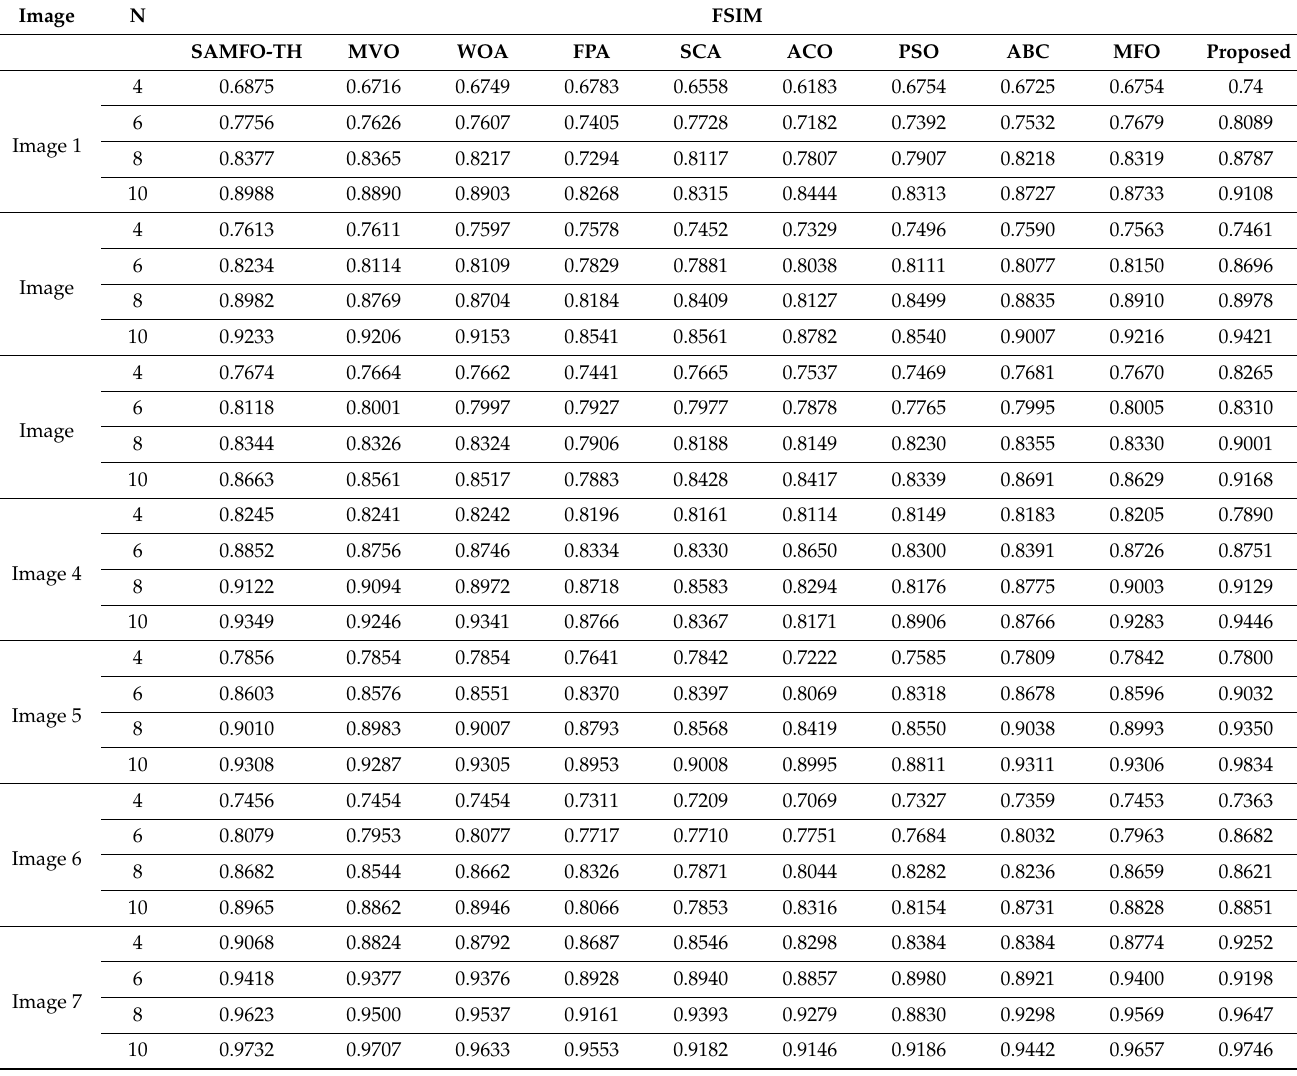
Table 5. Comparison of FSIM computed by SAMFO-TH, MVO, WOA, FPA, SCA, ACO, PSO, ABC, and MFO with the proposed model using Kapur’s method with N = 4, 6, 8, and